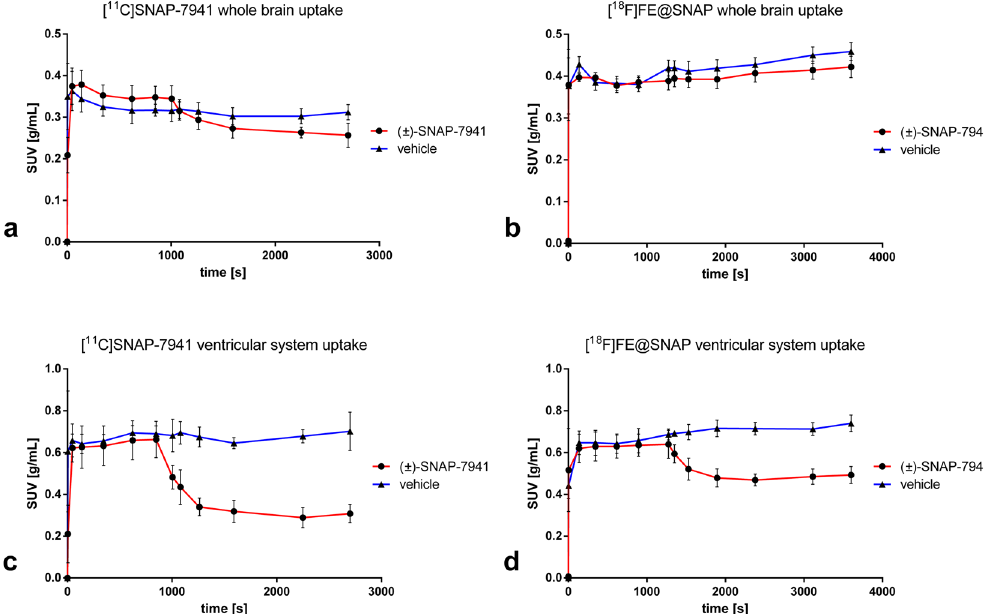
Figure 7. Time–activity curves of [ 11 C]SNAP-7941 and [ 18 F]FE@SNAP. Time–activity curves (mean SUV ± SEM) indicating the whole brain uptake of [ 11 C]SNAP-7941 ( a ) and [ 18 F]FE@SNAP ( b ) and the uptake in the ventricular system of [ 11 C]SNAP-7941 ( c ) and [ 18 F]FE@SNAP ( d ). Curves depict basal tracer kinetics followed by displacement with either 15 mg/kg ( ± )-SNAP-7941 (red line with circles) or the vehicle (blue line with triangles). Data are expressed as mean ± SEM from three independent experiments. If not visible, error bars are within the margin of the